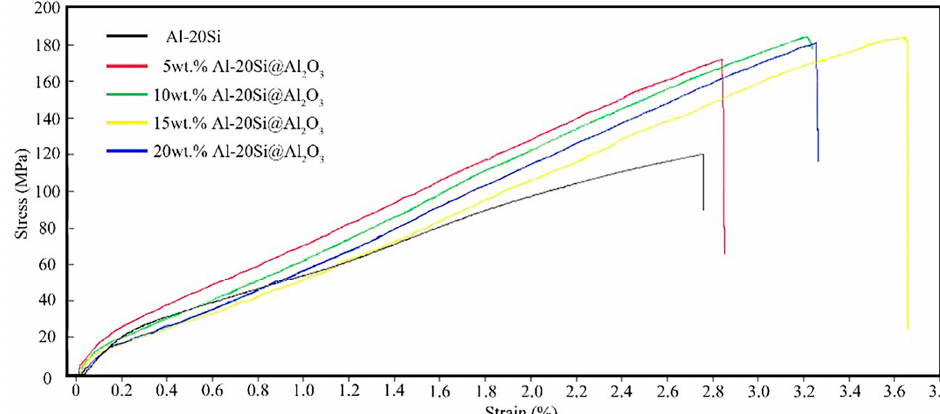
Figure 9. Tensile strength curves of Al–20Si with different additions.